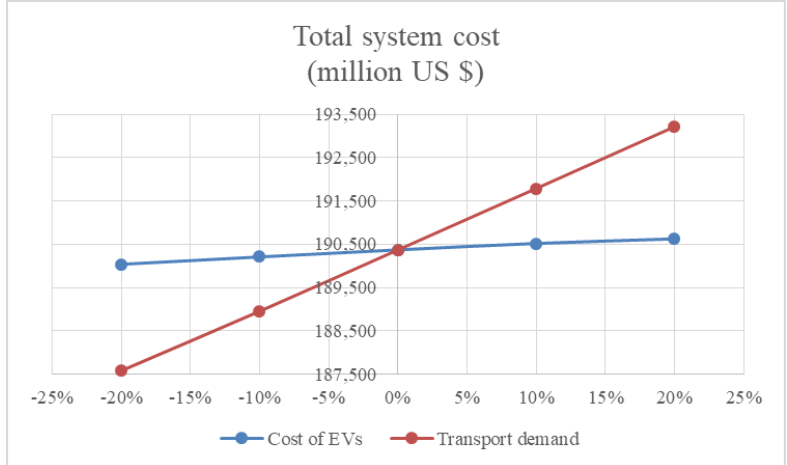
Figure 12. Total system cost change with different data for transport sector demand and cost of EVs in the base